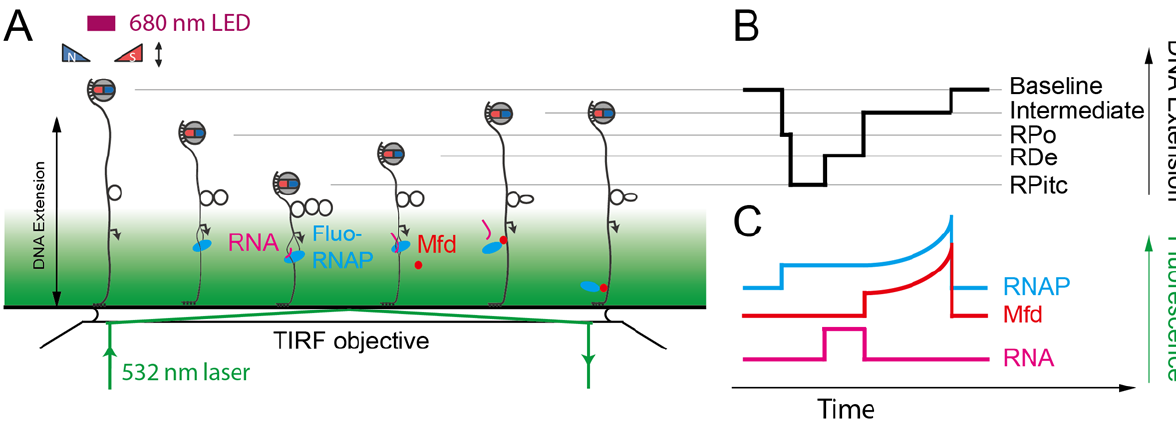
FIGURE 6: Sketch of the NanoCOSM assay (for nanomanipulation and colocalization of single-molecules) as applied to TCR. (A) An expo- nentially-decaying total-internal reflection field is added to the magnetic trap by introducing a laser line into the system (green line) such that it impinges, collimated, upon the glass- water interface of the sample at or above the critical angle σ c =sin -1 (n water /n glass ) – here σ c is the beam angle relative to axis normal to the interface, and n water and n glass are the indices of refraction of water and glass, respectively. (B) Magnetic trapping of the DNA allows one to monitor transcription-coupled repair as remodeling by Mfd of RNAP stalled on a DNA lesion and the concomitant formation of an intermediate extension state (labeled ‘intermediate’). The molecular composition of the mechanically - defined intermediate state naturally remains ambiguous based on the magnetic trapping data; it could include Mfd, or RNAP, or both. (C) Simultaneous single-molecule fluorescence detection of fluorescently labeled components of the reaction lifts the ambiguity and allows one to enumerate the components present on the DNA at each stage of the repair reaction. These experiments show that Mfd remodels RNAP, causing it to lose hold of the nascent RNA, but that thereafter the RNAP stays associated with Mfd. Fluorescence signatures of RNAP and Mfd increase after remodeling because Mfd remains on the DNA and translocates in the same direction as initial transcription, i.e. towards the surface, transporting its associated RNAP along as this permits the translocase to remain tightly bound to the DNA and highly